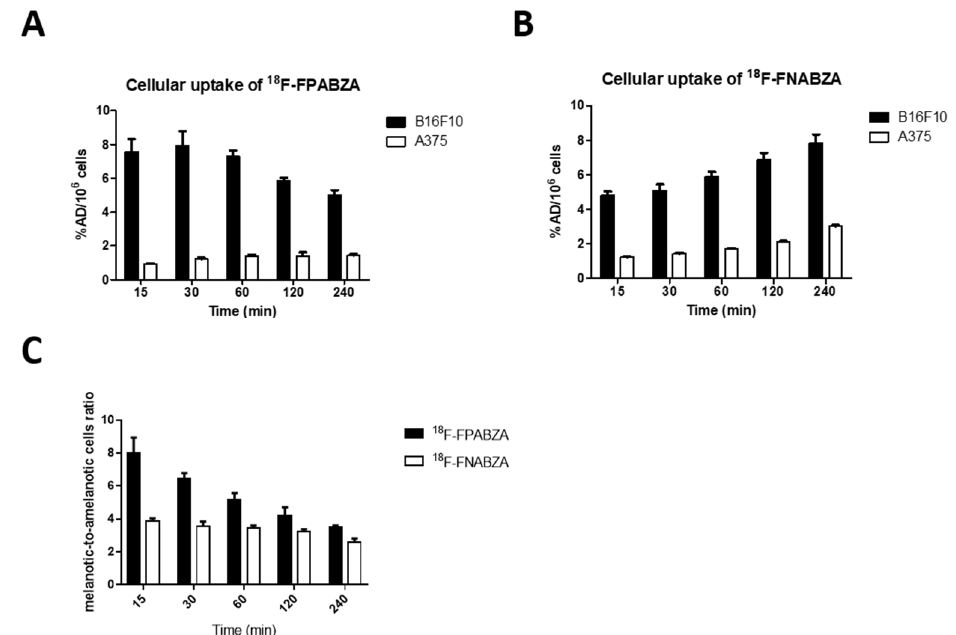
Figure 5. Cellular uptake of ( A ) 18 F-FPABZA and ( B ) 18 F-FNABZA in B16F10 murine melanoma and A375 human melanoma cells. ( C ) The melanotic-to-amelanotic cells ratios at each time points. The data are expressed as the mean ± SD ( n =